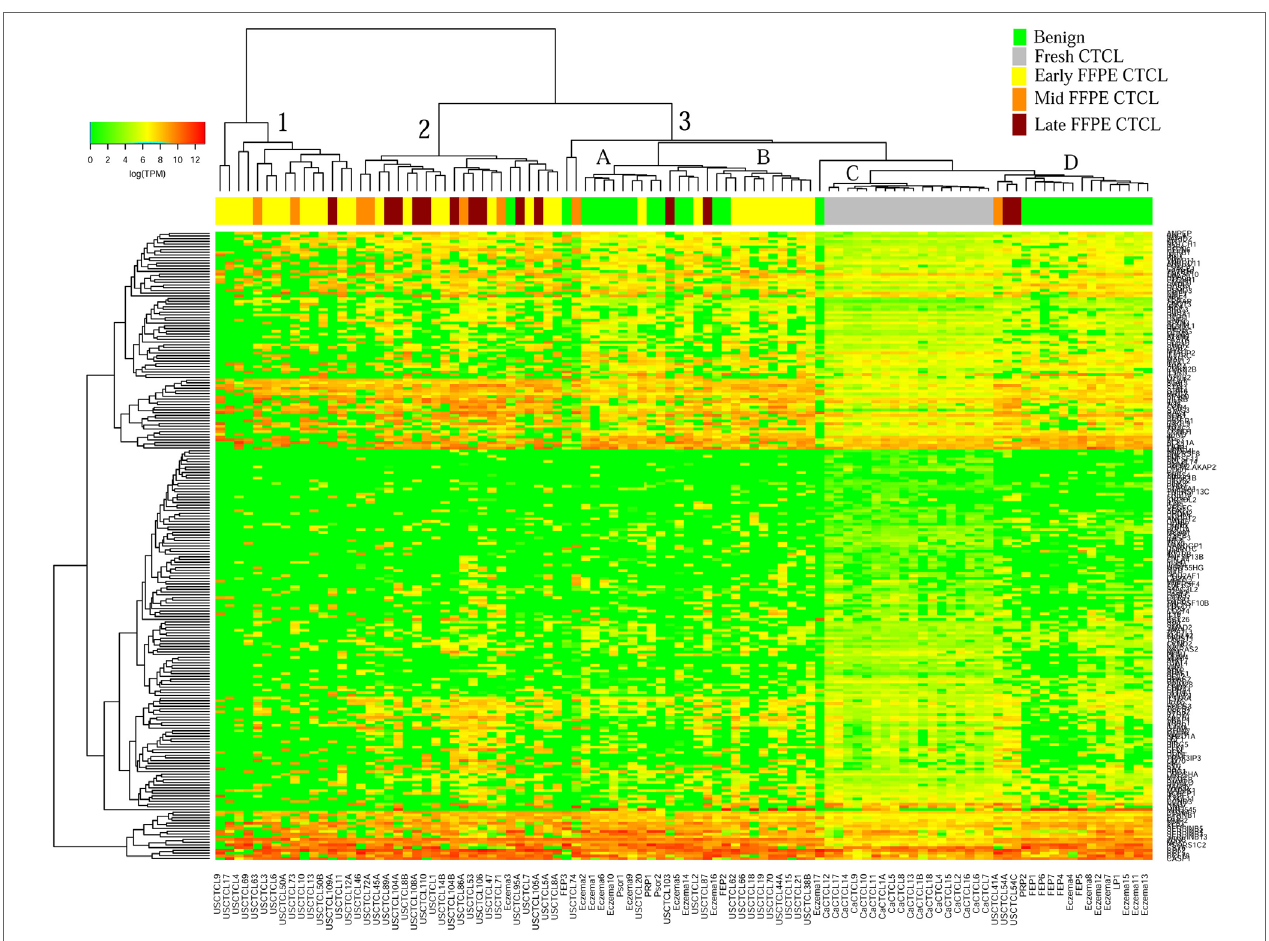
FigUre 1 | Unsupervised hierarchical clustering analysis based on TruSeq targeted RNA gene expression analysis of 284 select genes in benign inflammatory dermatoses (green), freshly obtained and snap-frozen cutaneous T-cell lymphoma (CTCL) samples (gray), and ≤ 2008 formalin-fixed paraffin-embedded (FFPE) CTCL samples (early stage, yellow; mid stage, orange; and late stage, dark red). A color key refers to gene expression in log(transcripts per